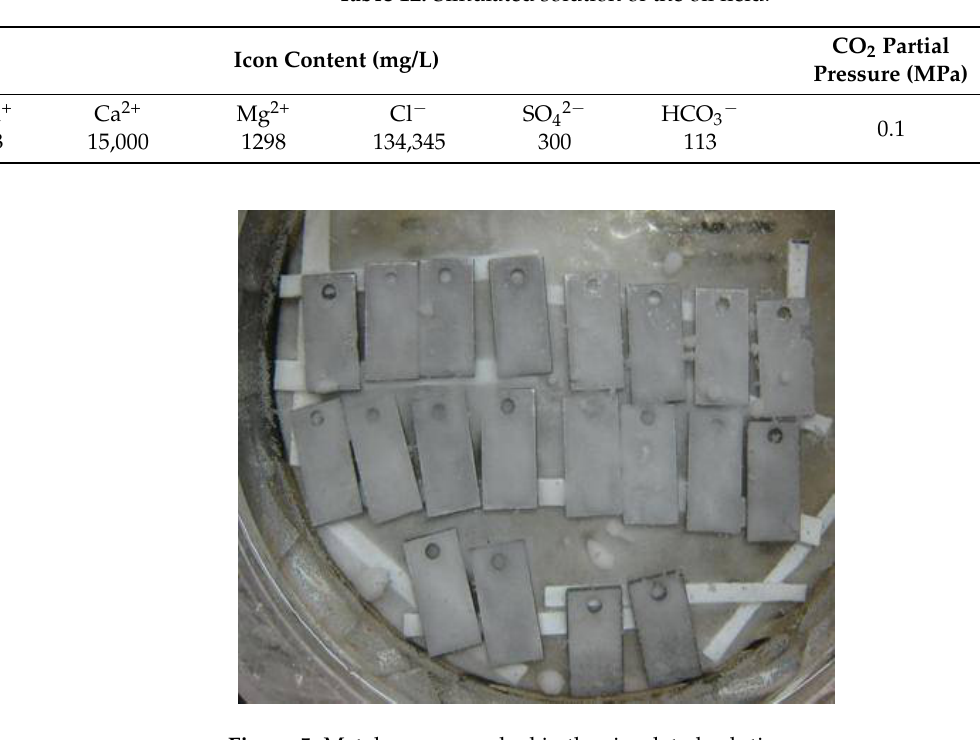
Figure 6. Average corrosion rate of different materials.